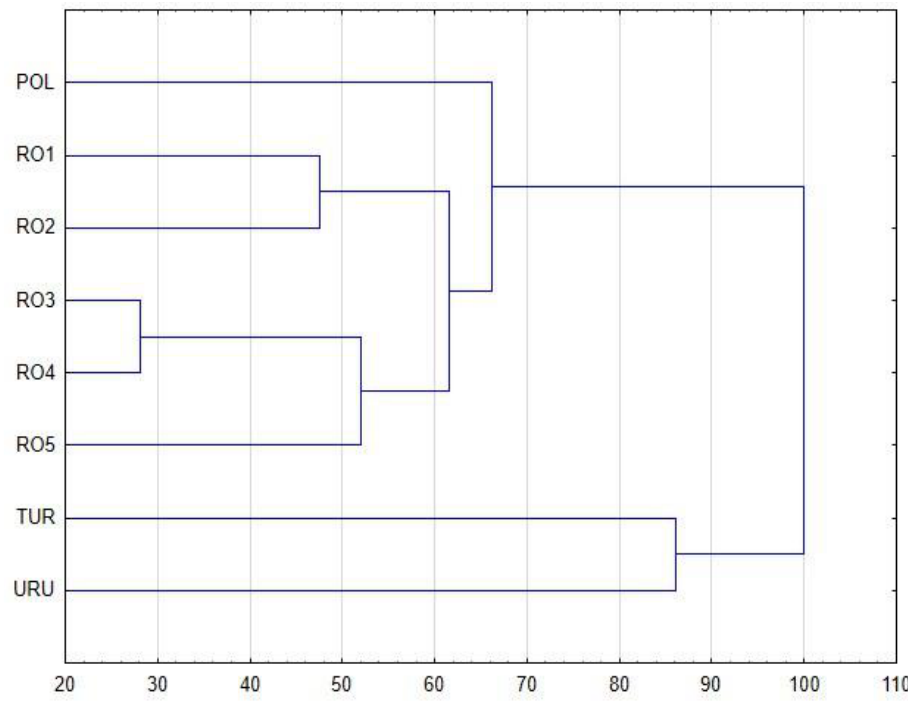
Figure 4. HCA dendrogram obtained by analysis of propolis of different origin.